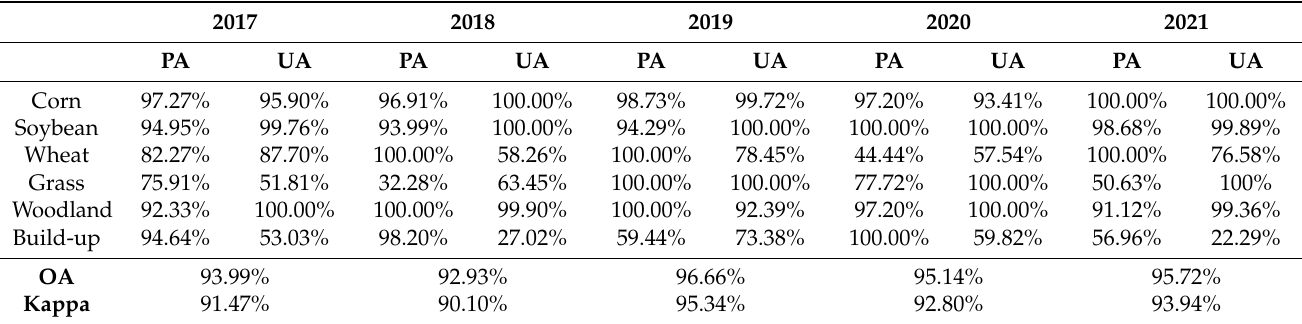
Table 3. The quantitative evaluation results of annual crop maps from 2017 to 2021. Four metrics were selected, including producer’s accuracy (PA), user’s accuracy (UA), overall accuracy (OA), and Kappa.